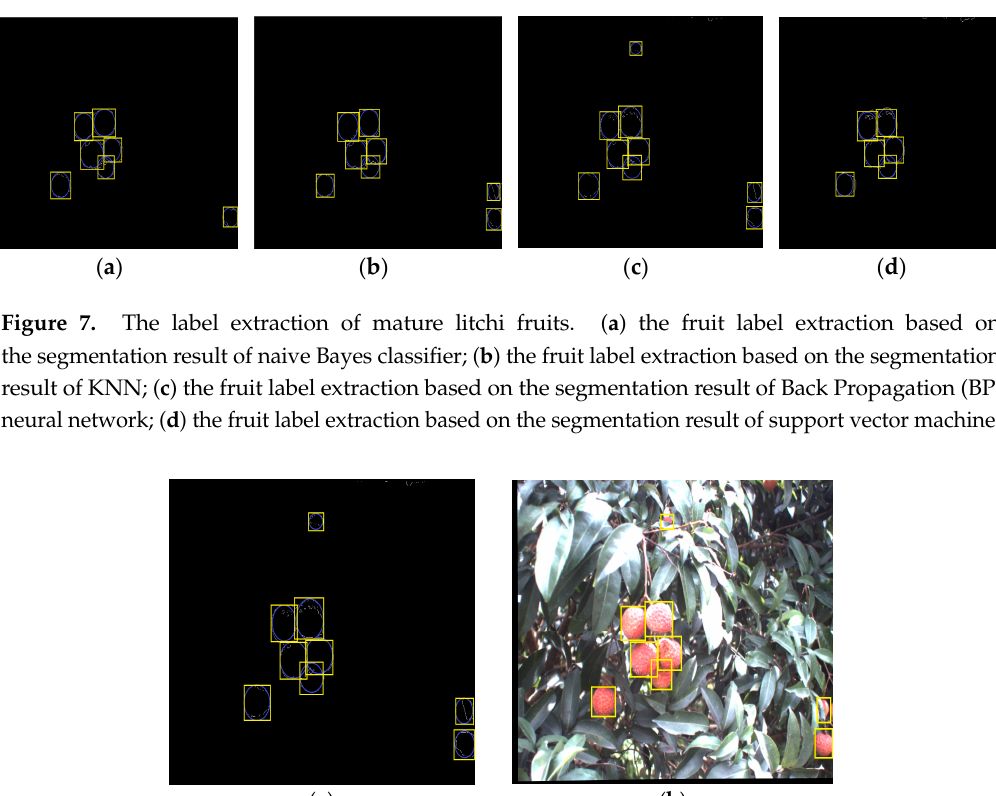
Figure 6. Mature litchi fruits extraction. ( a ) Original litchi color image; ( b ) Mature litchi fruit extraction based on Naive Bayes classifier; ( c ) Mature litchi fruit extraction based on KNN; ( d ) Mature litchi fruit extraction based on Back Propagation (BP) neural network; ( e ) Mature litchi fruit extraction based on support vector machine.